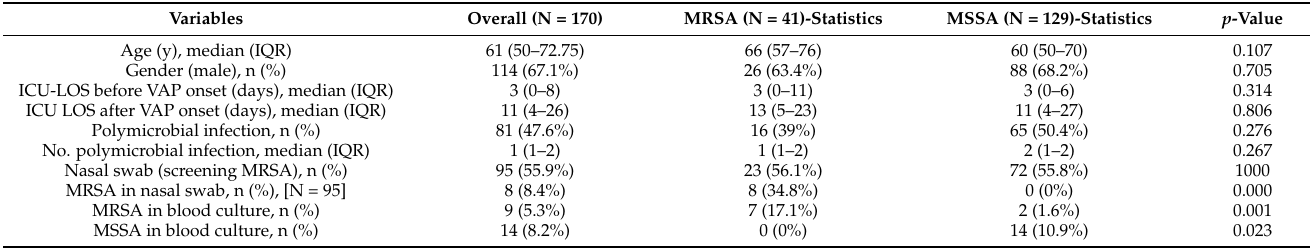
Table 1. Characteristics of patients with MSSA and MRSA VAP.